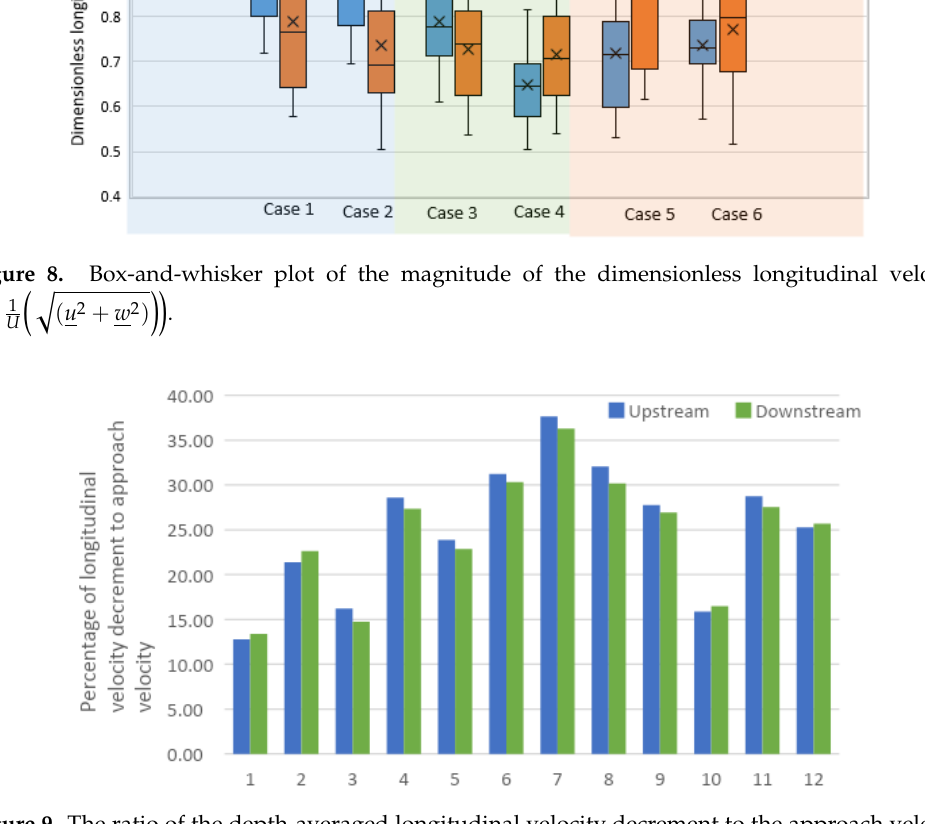
Figure 9. The ratio of the depth-averaged longitudinal velocity decrement to the approach velocity 0.02 m upstream and 0.02 m downstream of the spur dike.